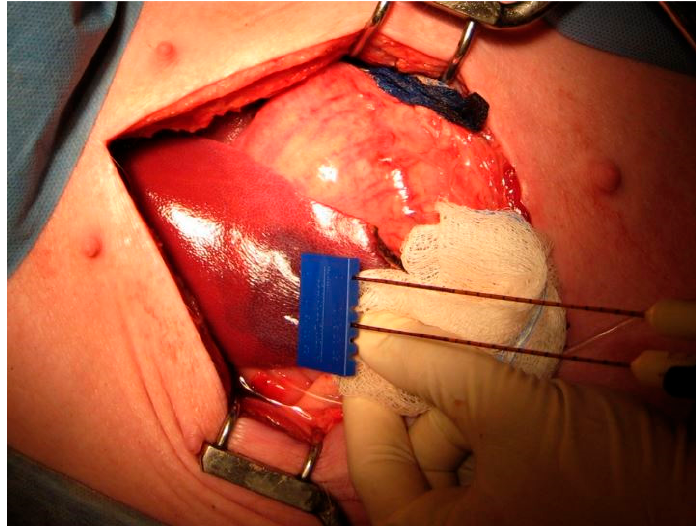
Figure 2. IRE ablation in a porcine liver. Dual IRE probes are spaced 1.5 cm apart on the surface of a pig liver. The dark red area adjacent to the probe tip indicates IRE-ablated liver tissue. Reproduced with permission from Au, J. et al., Surgery; published by Elsevier Inc., 2013.